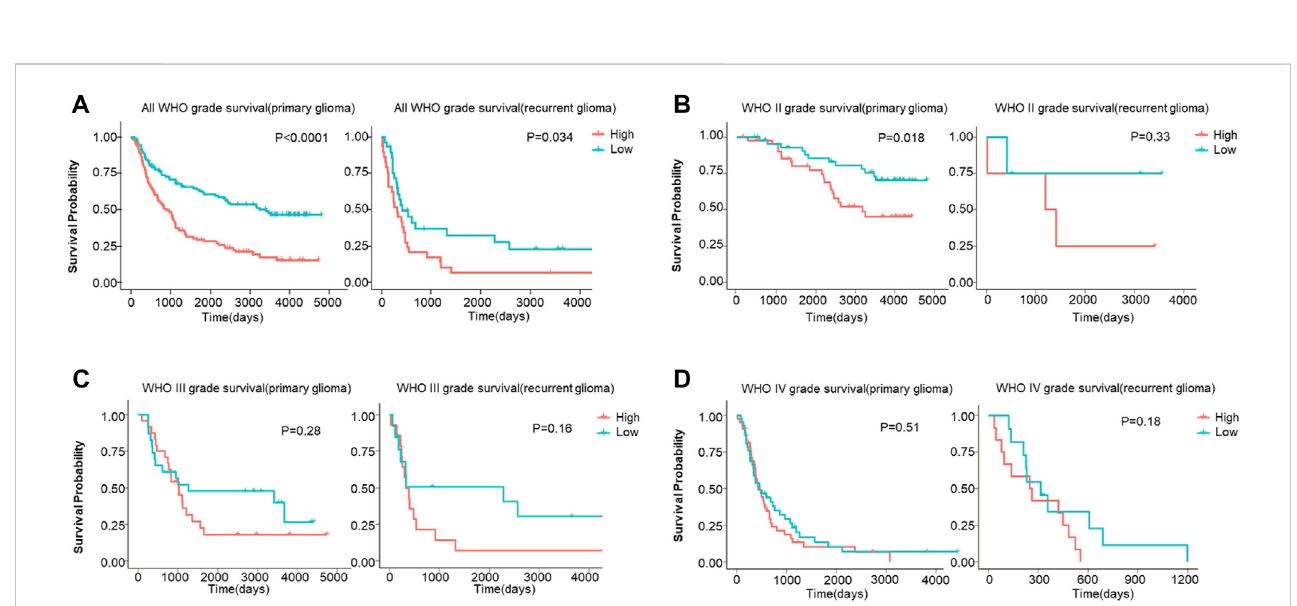
FIGURE 8 The overall survival (OS) analysis of FDX1 expression in glioma based on CGGA database. (A) FDX1 expression was related to OS in all WHO grade of primary glioma and recurrent glioma. (B – C) FDX1 expression was related to OS in LGG of primary glioma and recurrent glioma. (D) FDX1 expression was related to OS in GBM of primary glioma and recurrent glioma. (LGG: WHOII and WHO III grades, GBM: WHO IV grade, p < 0.05 was considered signi fi